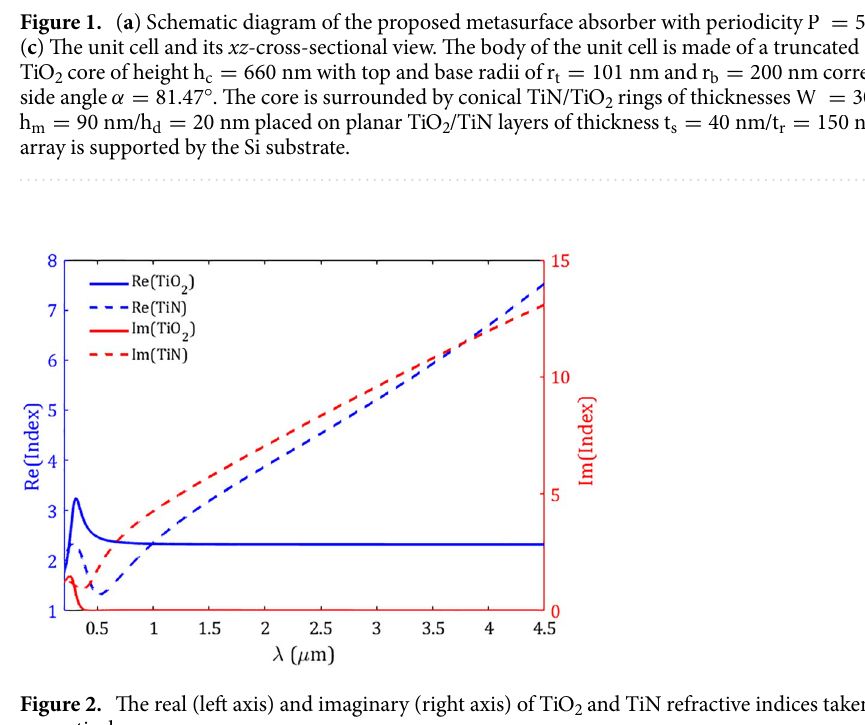
Figure 2. The real (left axis) and imaginary (right axis) of Ti O 2 and TiN refractive indices taken from 62,63 ,